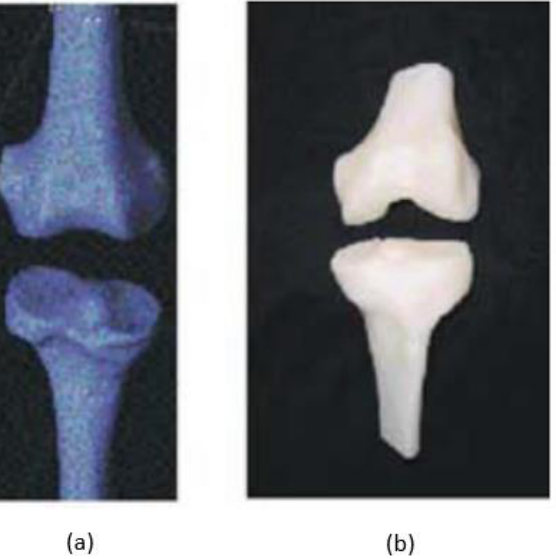
Figure 18. ( a ) Geometric model and ( b ) FDM prototype of femur and tibia. Adapted with permission from Revilla-León et al. [206]. 2002, IOP Conference Science.